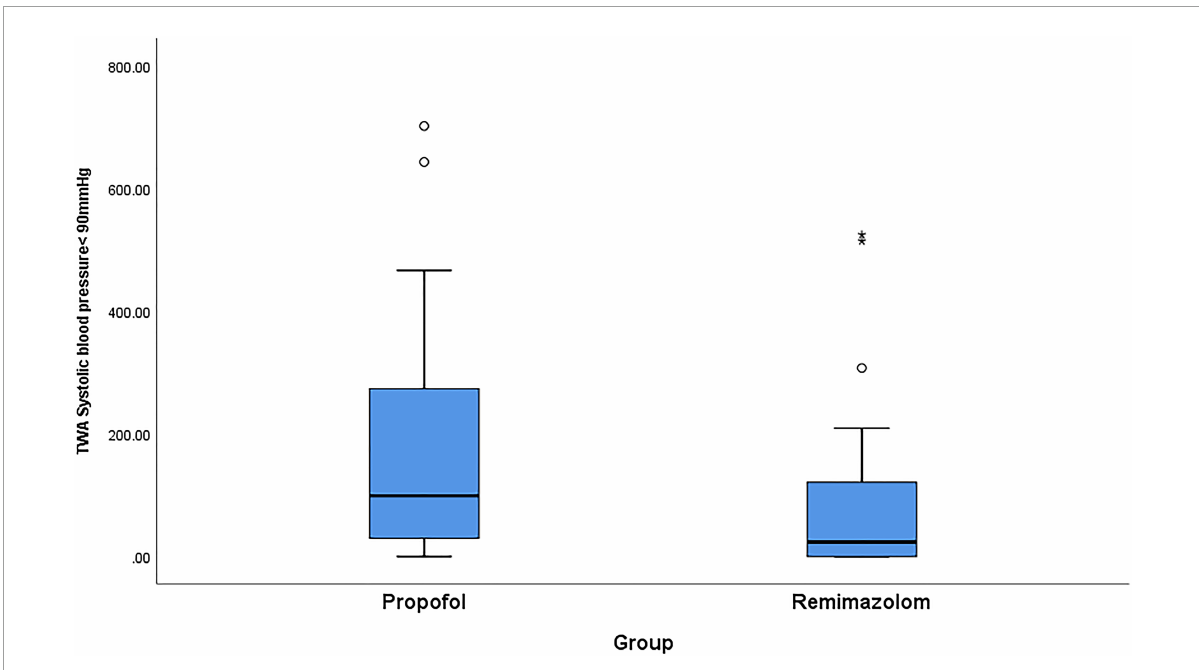
FIGURE2 Comparison of propofol and remimazolam on time-weighted average of intraoperative hypotension. Boxplots are showed with the lines in the box represent median [Q1, Q3] of the observed TWA hypotension and the whiskers extended to the minimum at the bottom and the maximum on top. Abbreviation: TWA, time-weighted average. Intraoperative hypotension was defined as systolic blood pressure less than 90 mmHg. Q1 and Q3 represent 25th and 75th of the TWA hypotension.